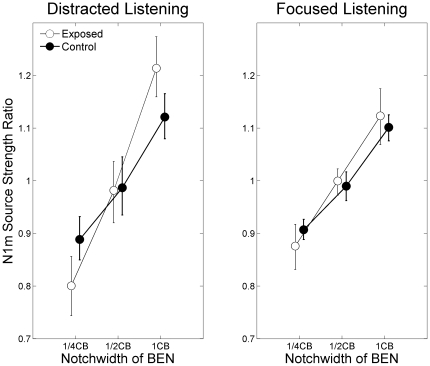
Normalized N1m source strength.The graphs display the group means (N = 13) of the normalized N1m source strengths for each band-eliminated noise (BEN) condition during distracted (left panel) and focused (right panel) listening. Open and filled circles represent the exposed and control groups with the error bars denoting the 95% confidence limits.